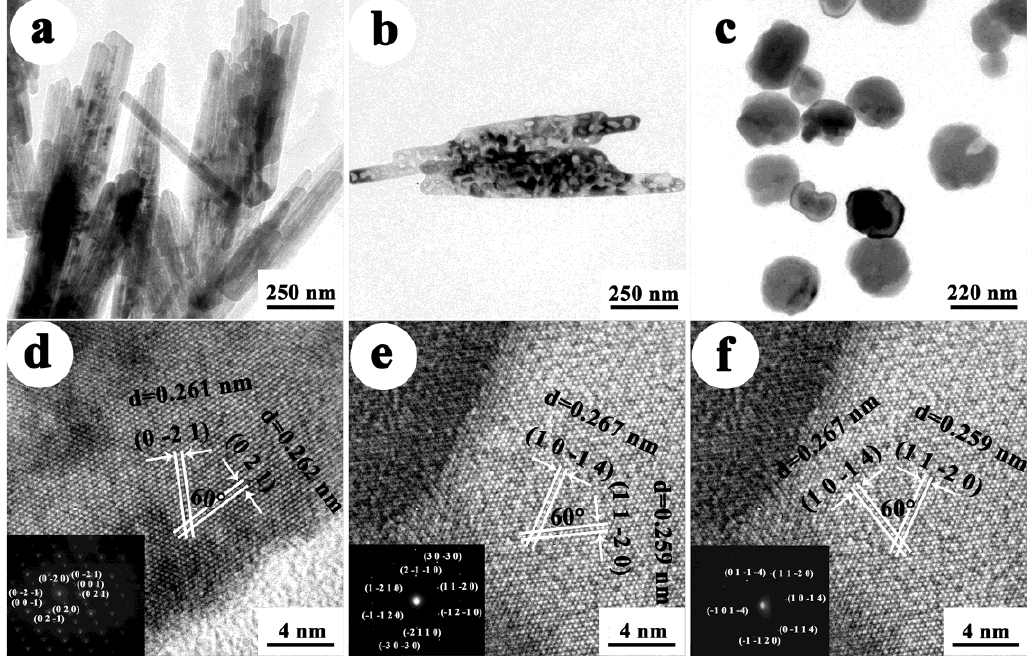
Figure 2. TEM images of different iron-based samples of the α -FeOOH nanorod ( a ) , α -Fe 2 O 3 na- norod ( b ), and α -Fe 2 O 3 nanodisk ( c ). HRTEM images of different iron-based samples of the